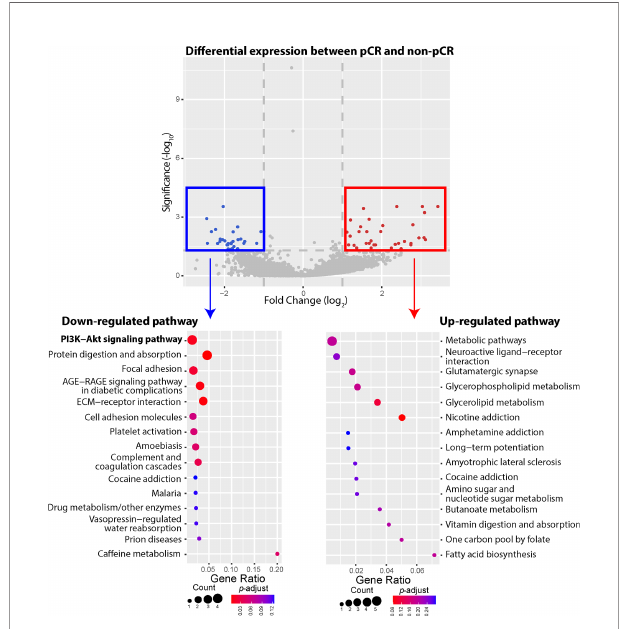
FIGURE 4 | Differentially expressed genes (DEGs) and up-/down-regulated signaling pathways between pathologic complete response (pCR) patients or non-pathologic complete response (non-pCR) patients. A total of 61 DEGs were identi fi ed between the pCR subgroup and the non-pCR subgroup, including 34 genes expressed at higher levels and 27 genes expressed at lower levels, in the pCR subgroup, with absolute fold-change greater than 2. The phosphatidylinositol-3-kinase-AKT (PI3K-AKT) pathway was signi fi cantly down regulated among patients achieving pCR, with 4 lower expressed genes. Other down-regulated pathways included protein digestion and absorption, focal adhesion, AGE-RAGE, ECM-receptor, etc. On the other hand, higher expressed genes belonged to the pathways of metabolic pathways, neuroactive ligand-receptor interaction, glutamatergic synapse, glycerophospholipid metabolism, glycerolipid metabolism, nicotine addiction pathways,